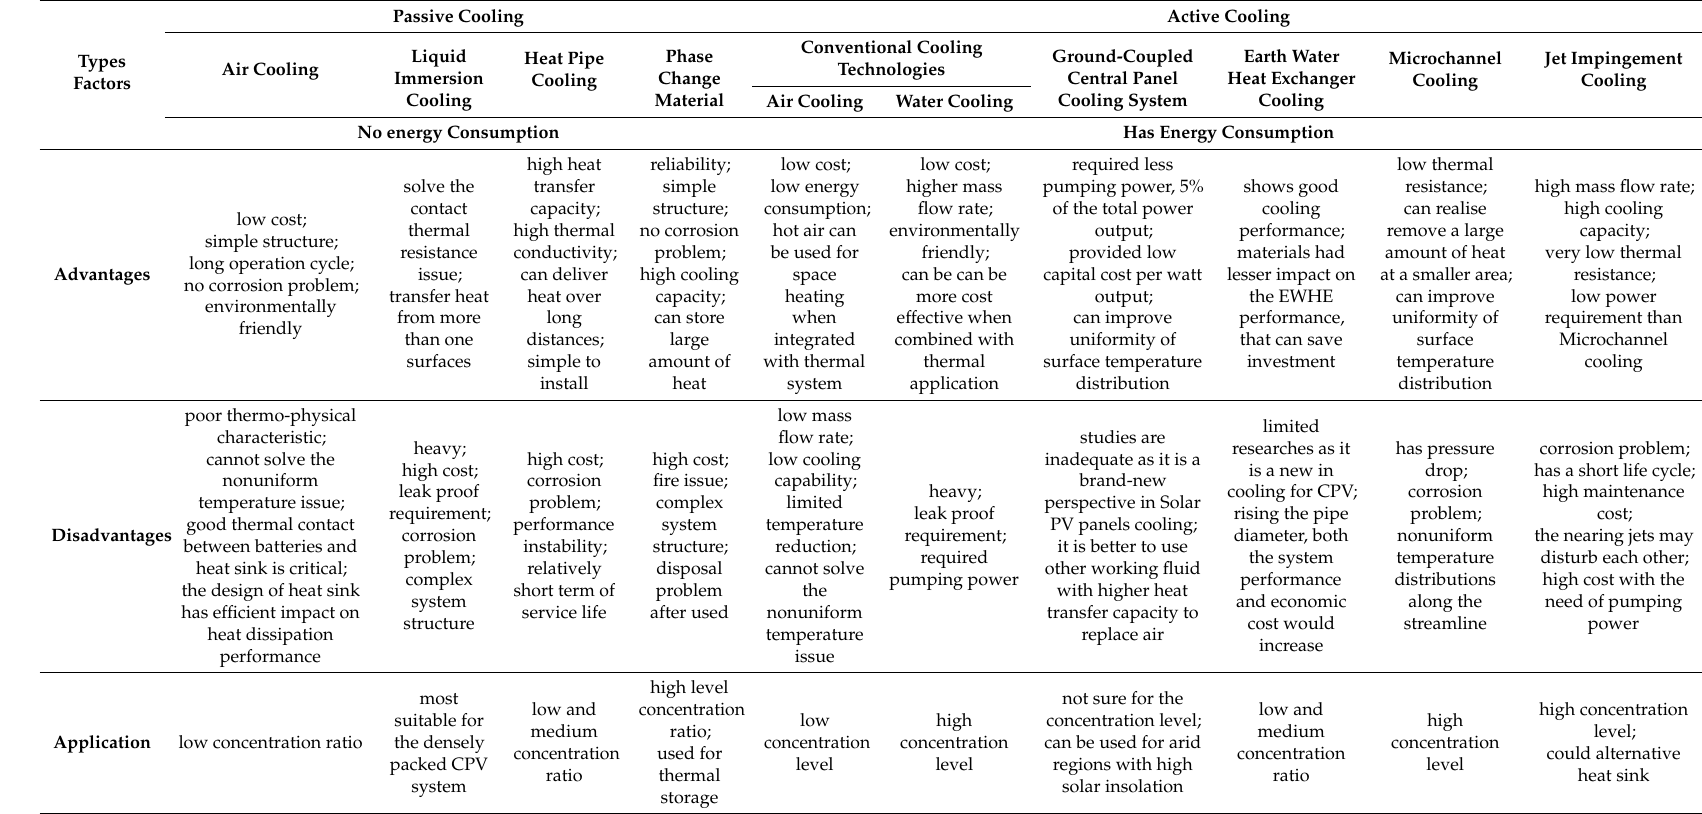
Table 3. Comparative study of different cooling techniques for CPV